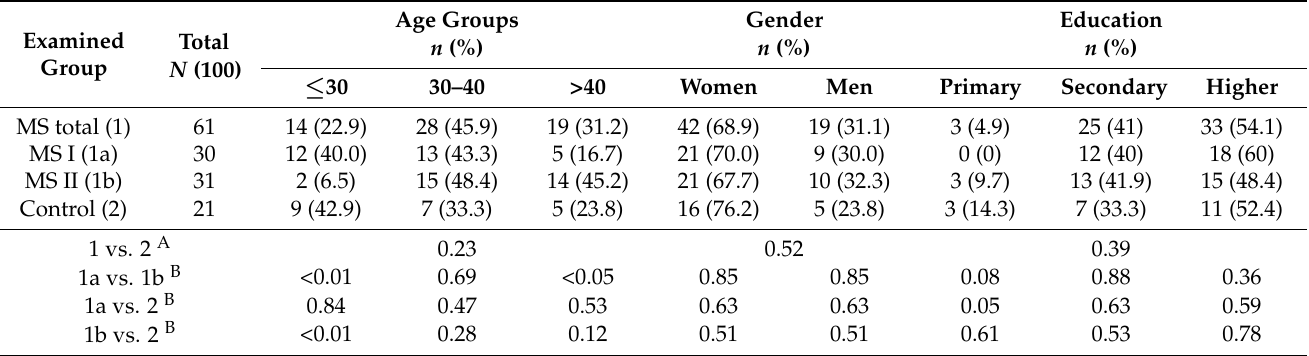
Table 1. Sociodemographic characteristics of examined